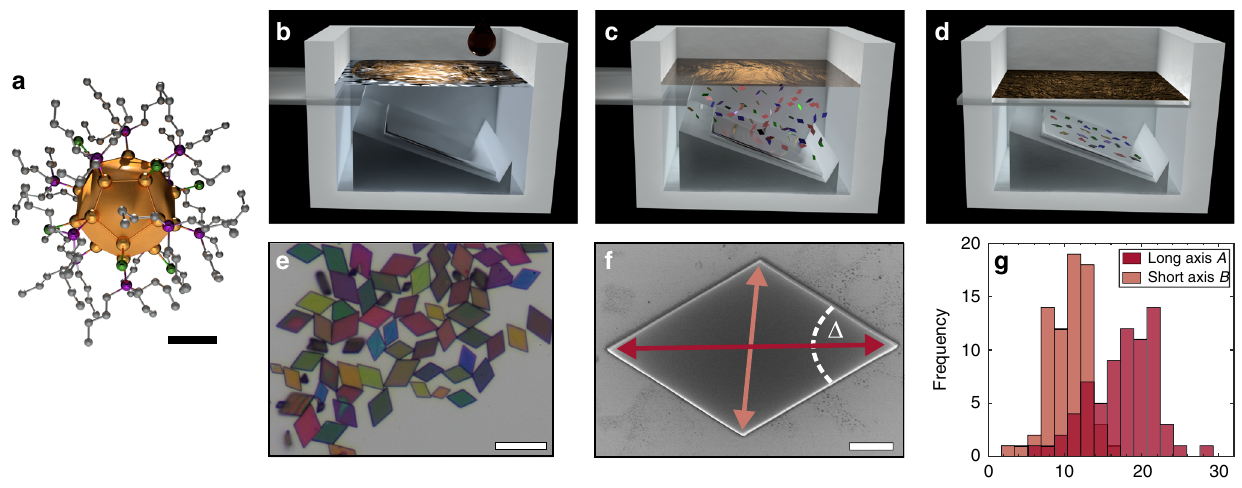
Fig. 1 Au 32 -NC self-assembly into microcrystals. a Structural drawing of the Au 32 ( n Bu 3 P) 12 Cl 8 -NCs. The different colors represent the Au- (gold), Cl- (green), P- (purple), and C- (gray) atoms, while hydrogens are omitted for clarity. The Au core has a diameter of ~0.9 nm, while the size of the entire NC is about 1.3 nm. Scale bar: 0.4 nm. b – d Schematic illustration of the assembly process. An Au 32 -NC solution is injected onto the liquid subphase within a Te fl on chamber. The Au 32 -NCs self-assemble into microcrystals and sink down through the subphase onto the immersed substrate. Details are given in the “ Methods ” section. e Optical micrograph of self-assembled Au µ m-sized and exhibit a 32 -NC microcrystals on a Si/SiO x substrate. The crystals are parallelogram shape. Different sizes and thicknesses (color) can be observed. Scale bar: 15 µ m. f SEM micrograph of a microcrystal with indicated long axis A , short axis B , and angle Δ . Scale bar: 2 µ m. g Distribution of long and short axis revealing typical crystal sizes of A = 17.4 ± 4.2 µ m, B = 10.6 ± 2.5 µ m (dispersity of Đ = 1.07, see Supplementary Information for details).